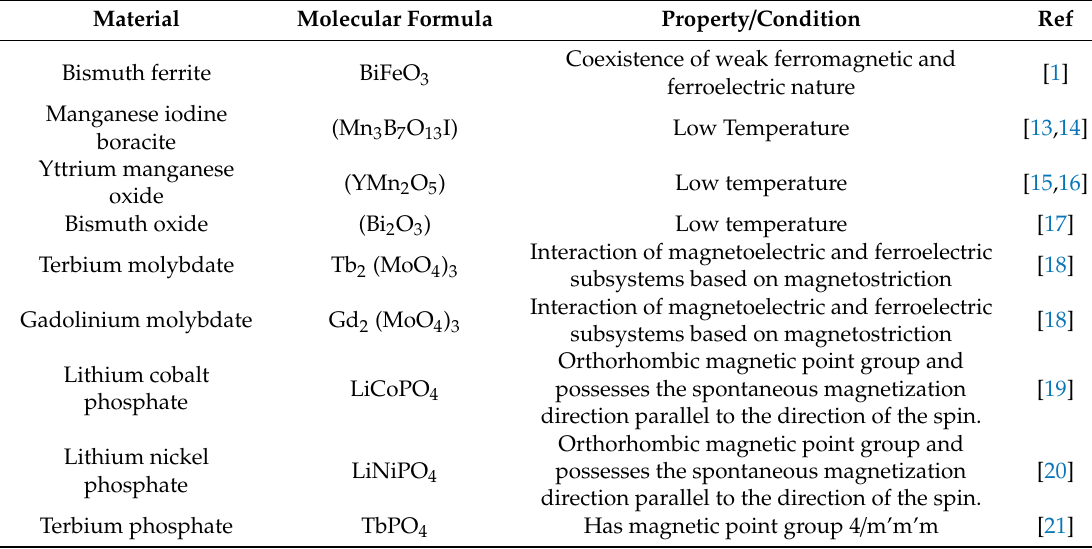
Table 1. List of some materials showing magnetoelectric behavior and the property / condition essential for the same.